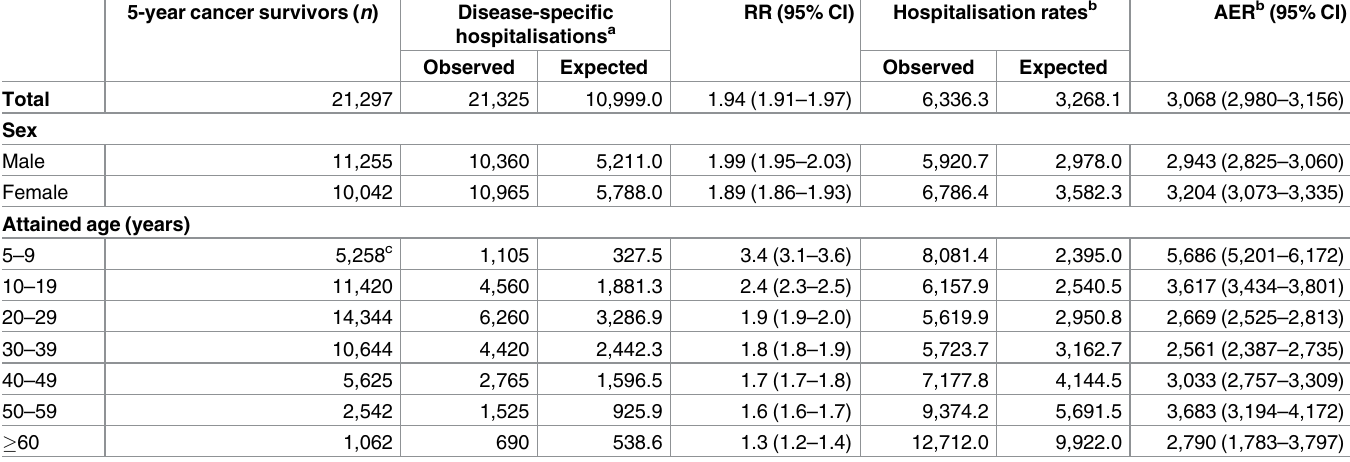
Table 2. Observed and expected numbers of hospitalisations by sex and attained age in 21,297 5-yearsurvivors of childhood cancer in the Nordic countries. 5-year cancer survivors ( n